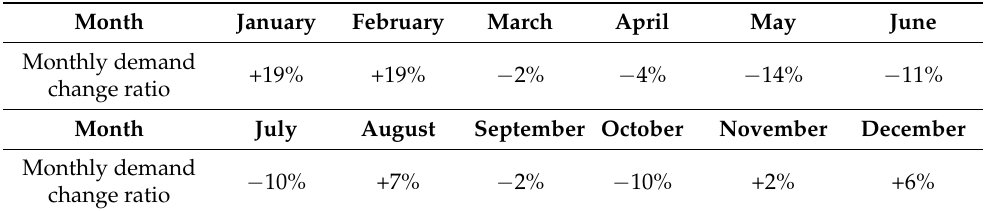
Table 1. The rate of the monthly change in average energy demand.